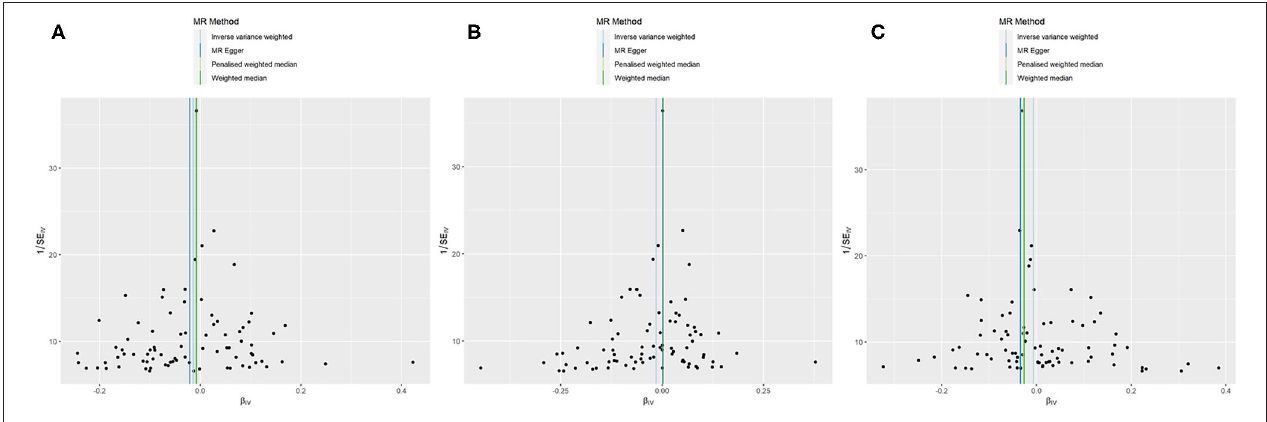
FIGURE 5 | MR funnel plots: AF for FEV1 (A) ; AF for FVC (B) ; AF for FEV1/FVC (C) .